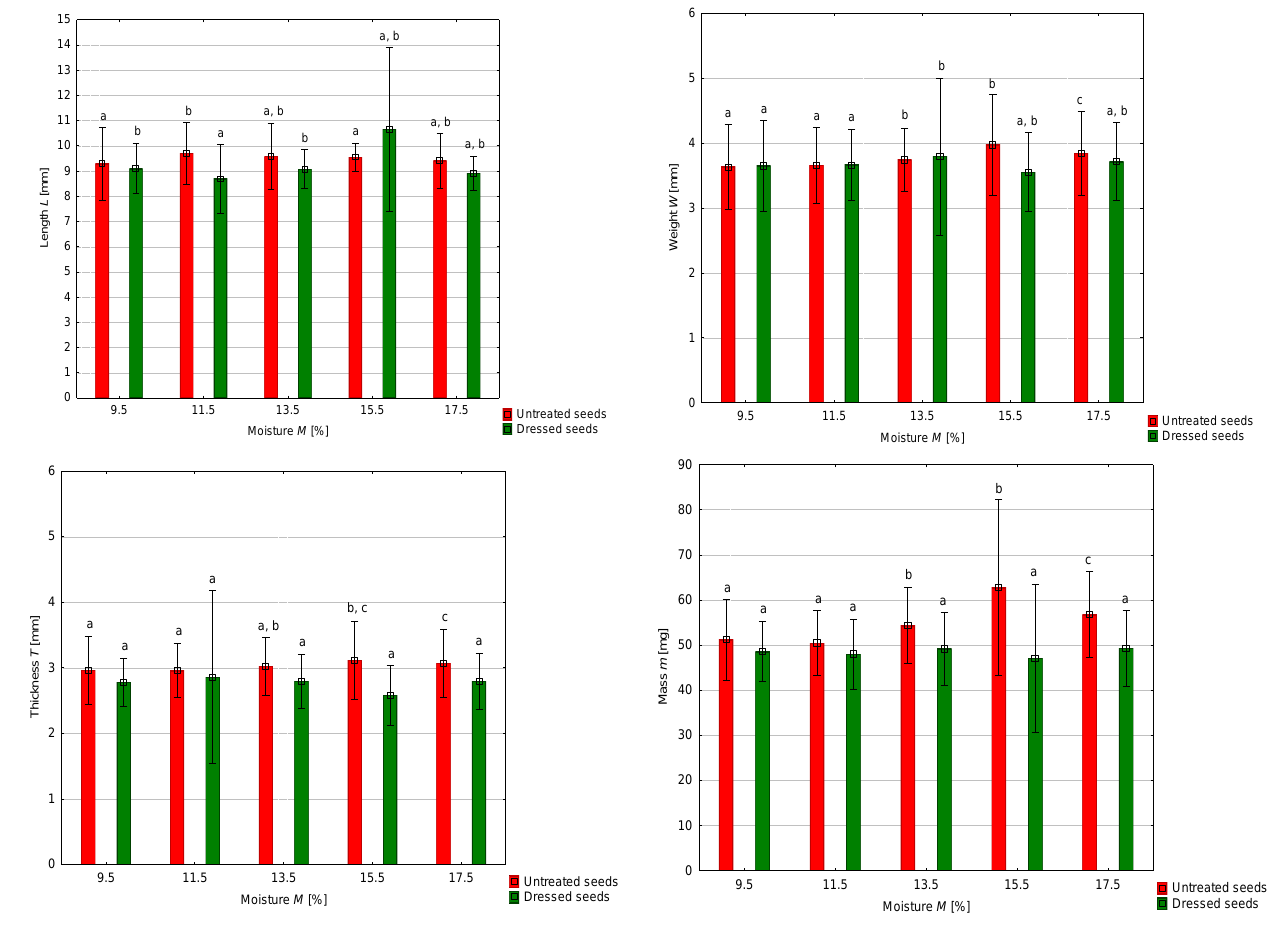
Figure 4. The physical parameters (the mean value and standard deviation) of winter barley seeds.